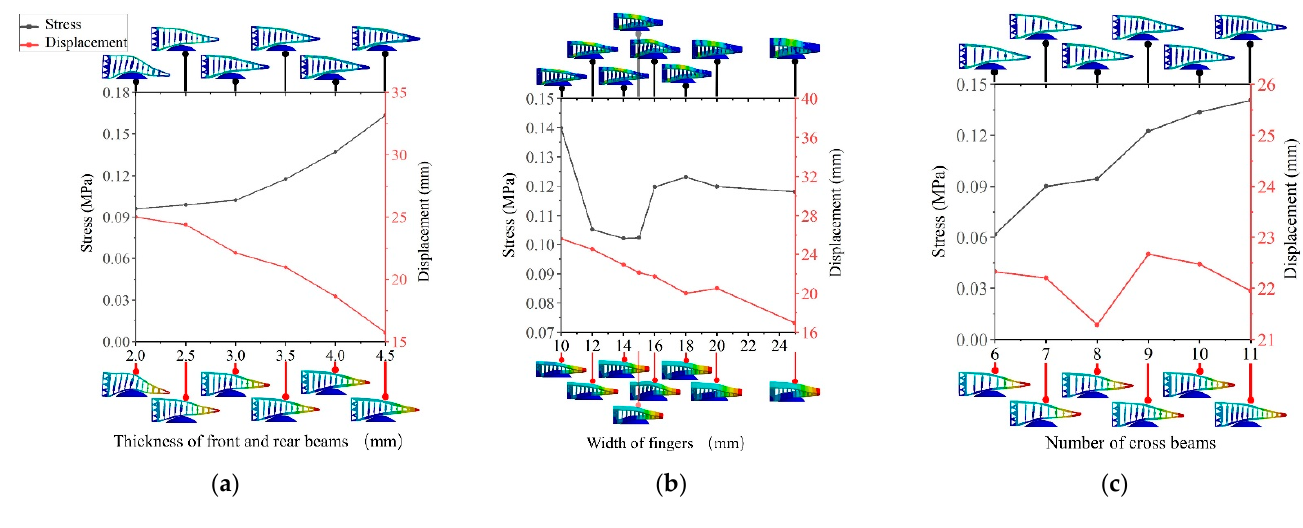
Figure 3. Changes in stress and displacement according to three factors: ( a ) thickness of front and rear beams; ( b ) width of fingers; ( c ) number of cross beams.